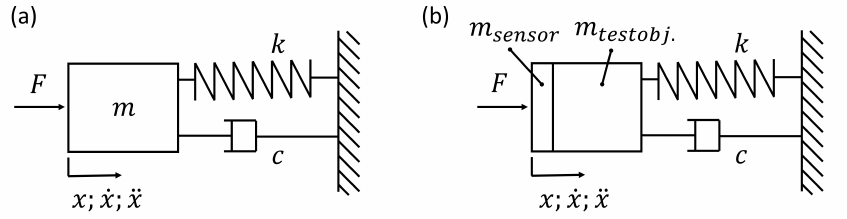
Figure 1. ( a ) mechanical model of a mass-damper-spring system; ( b ) mass separated into m sensor and m testobj